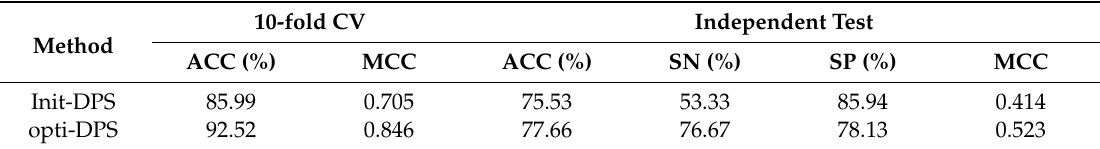
Table 4. Comparison between PVPred-SCM based on optimized (opti-DPS) and initial (init-DPS) dipeptide propensity scores assessed by 10-fold cross-validation and independent validation